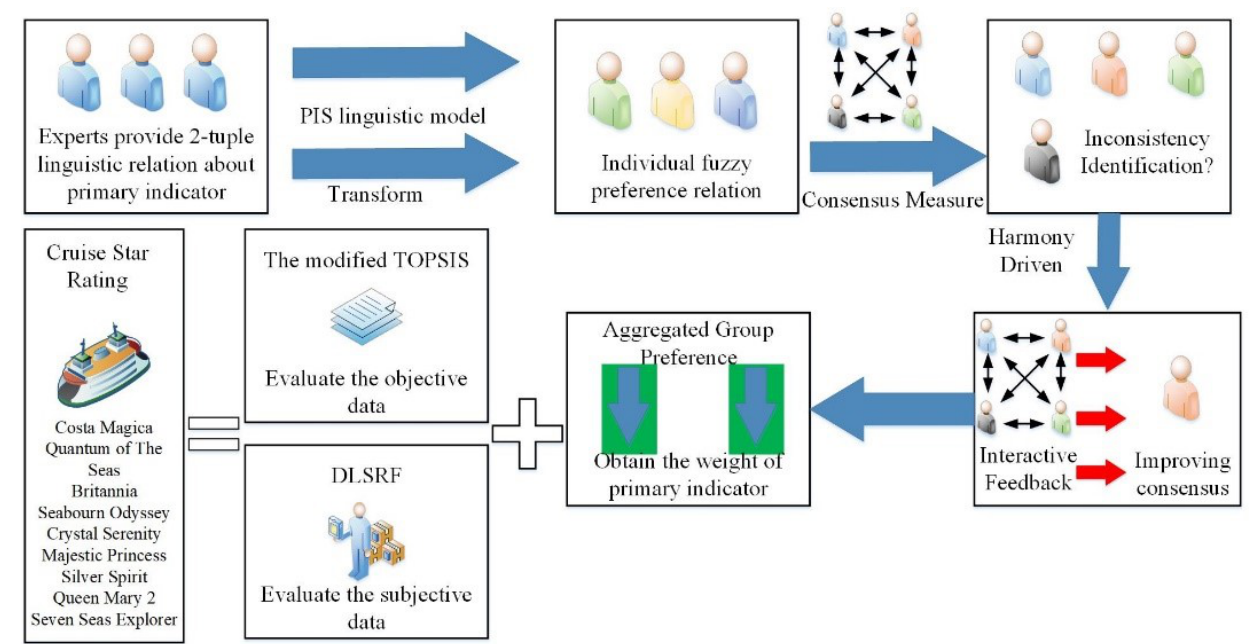
Figure 2. The Weaving Diagram of Technical